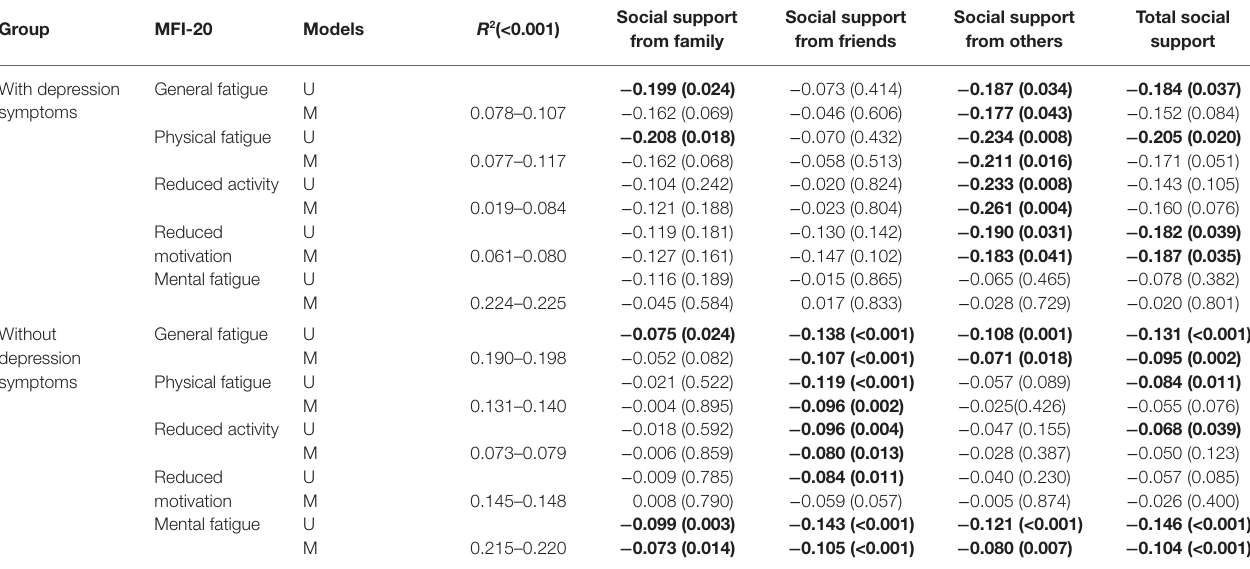
TABLE 2 | Association between the Perceived social support and the subscales of the MFI-20 stratified by depression symptoms. Group MFI-20 Models R 2